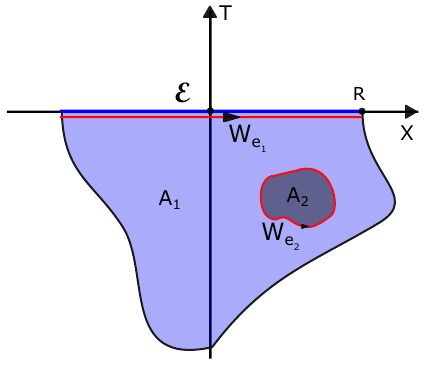
Figure 6 . Volume-regularized path integral. Figure 7 . Example of a general Euclidean path integral with Wilson loop and line